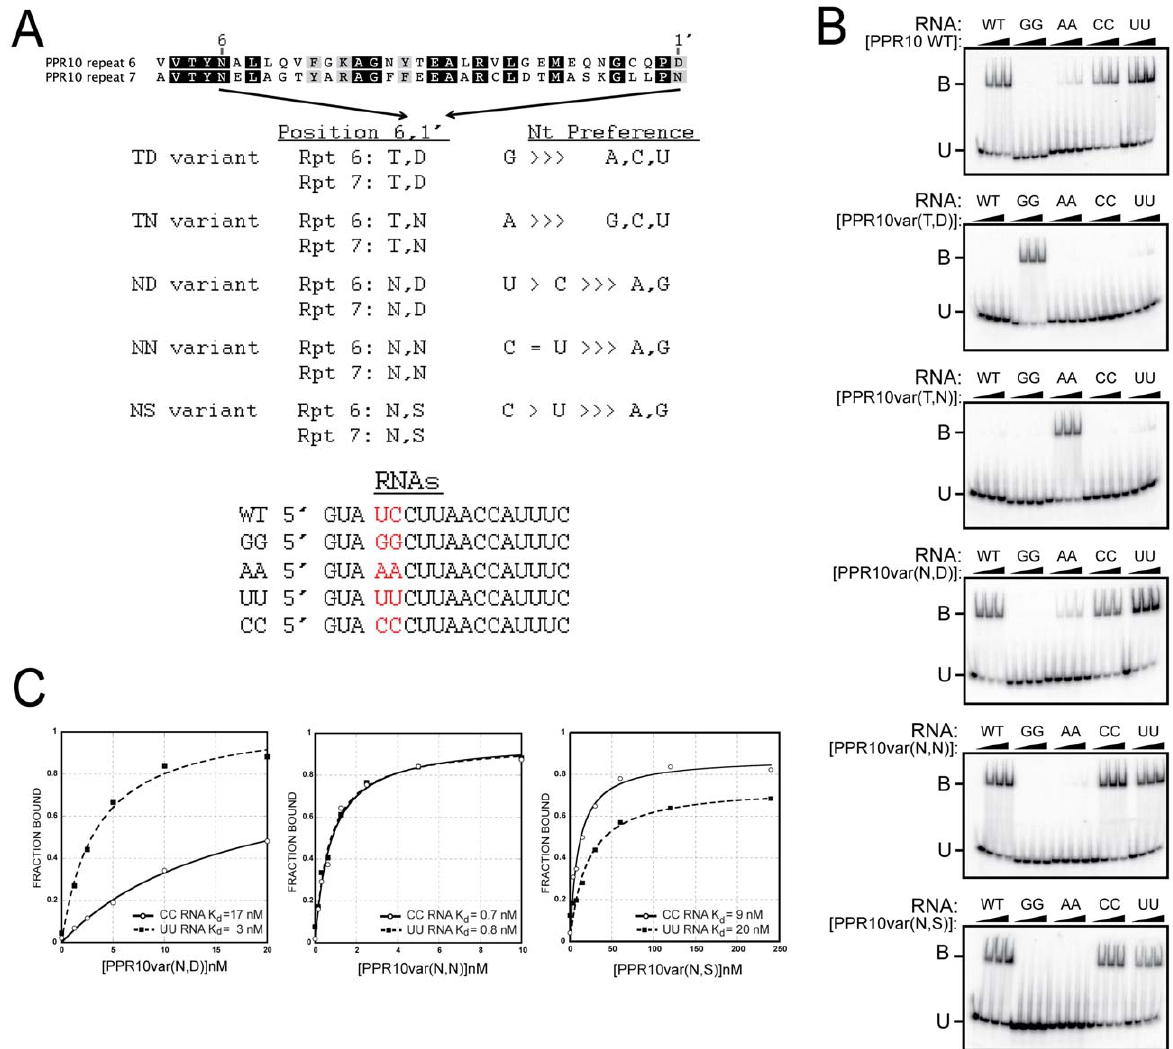
Figure 5. Gel Mobility Shift Assays Validating Amino Acid Codes for Specifying PPR Binding to A, G, C, or U. (A) Summary of rPPR10 variants. The same amino acids at positions 6 and 1 9 were introduced into the sixth and seventh PPR motifs in PPR10, whose wild-type sequences are shown above. The RNAs used for binding assays are shown below. (B) Gel mobility shift assays with the wild-type RNA, or variants with nucleotides four and five substituted with either GG, AA, UU, or CC. (C) Binding curves of the NN, ND, and NS PPR10 variants with the UU and CC substituted RNAs.